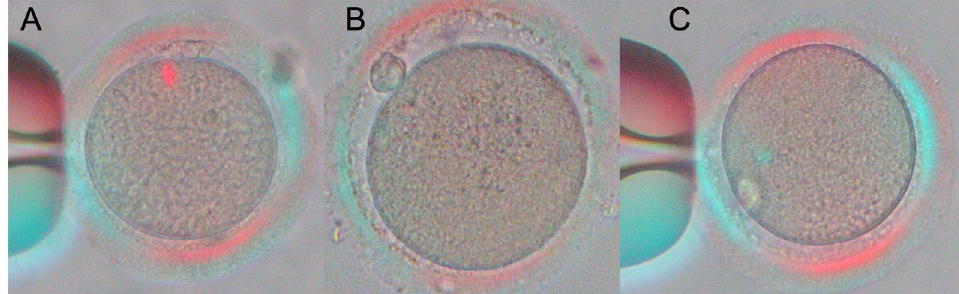
Figure 3. Oocyte maturation indicated by PB/MS proximity and MS visibility, captured by polarized light microscopy and presented without postprocessing adjustments. ( A ) The oocyte with PB and MS in close proximity; ( B ) the oocyte with no visible MS. ( C ) The oocyte with visible PB and MS not in close proximity, oocyte was rotated to determine the optimal morphology and location of MS. Photos were taken on microscope of Nikon Europe B.V., Czech Branch Office, Microscope Nikon Eclipse Ti2 Series, Nikon Spindle Observation System. Microscopic images were taken at ×100 mag- nification.